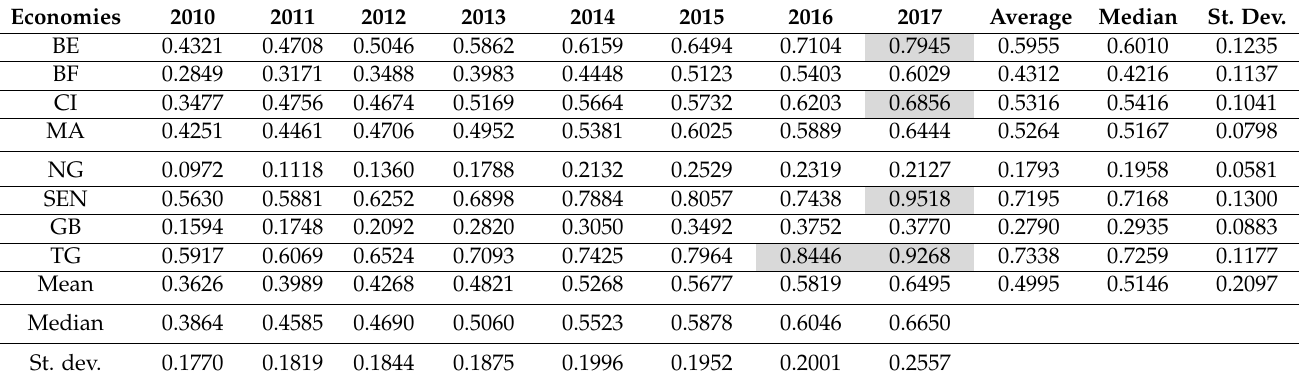
Table 7. AS–CEA—Descriptive